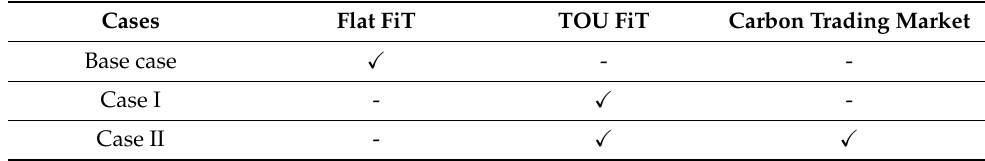
Figure 2. Insolation in Iran at 12:00 p.m. local time in June. Table 4. Conditions of different cases defined for the Table 3. Average daily insolation in the eight different zones.